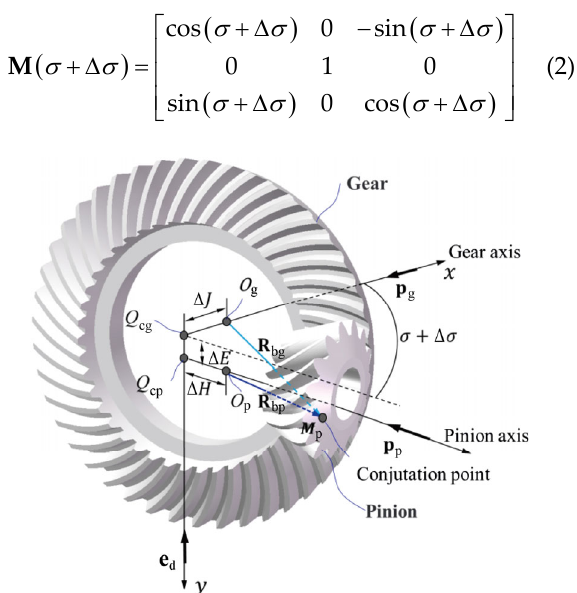
Fig. 1 Assembling position between the pinion and